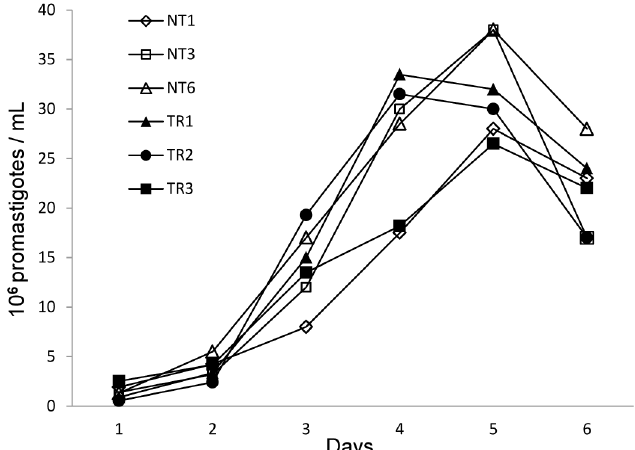
Fig 1. Promastigote growth curves of strains from the non-treated (NT) and treated relapsed (TR) groups. No significant differences were found between promastigote counts for any of the isolates on respective days (Repeated measures ANOVA with Greenhouse-Geisser tests, P =